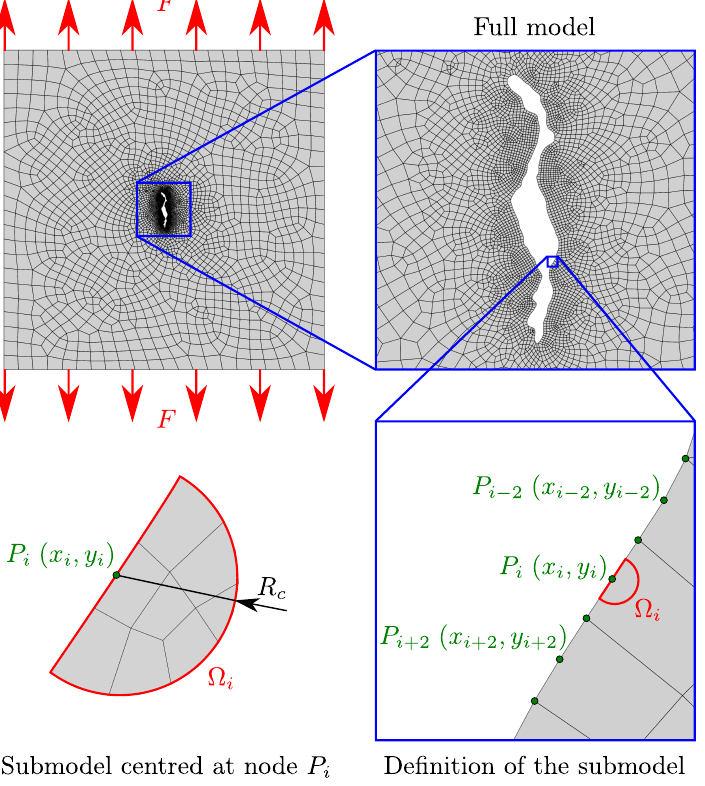
Figure 10. Simulation strategy to assess defect-afflicted cast steel